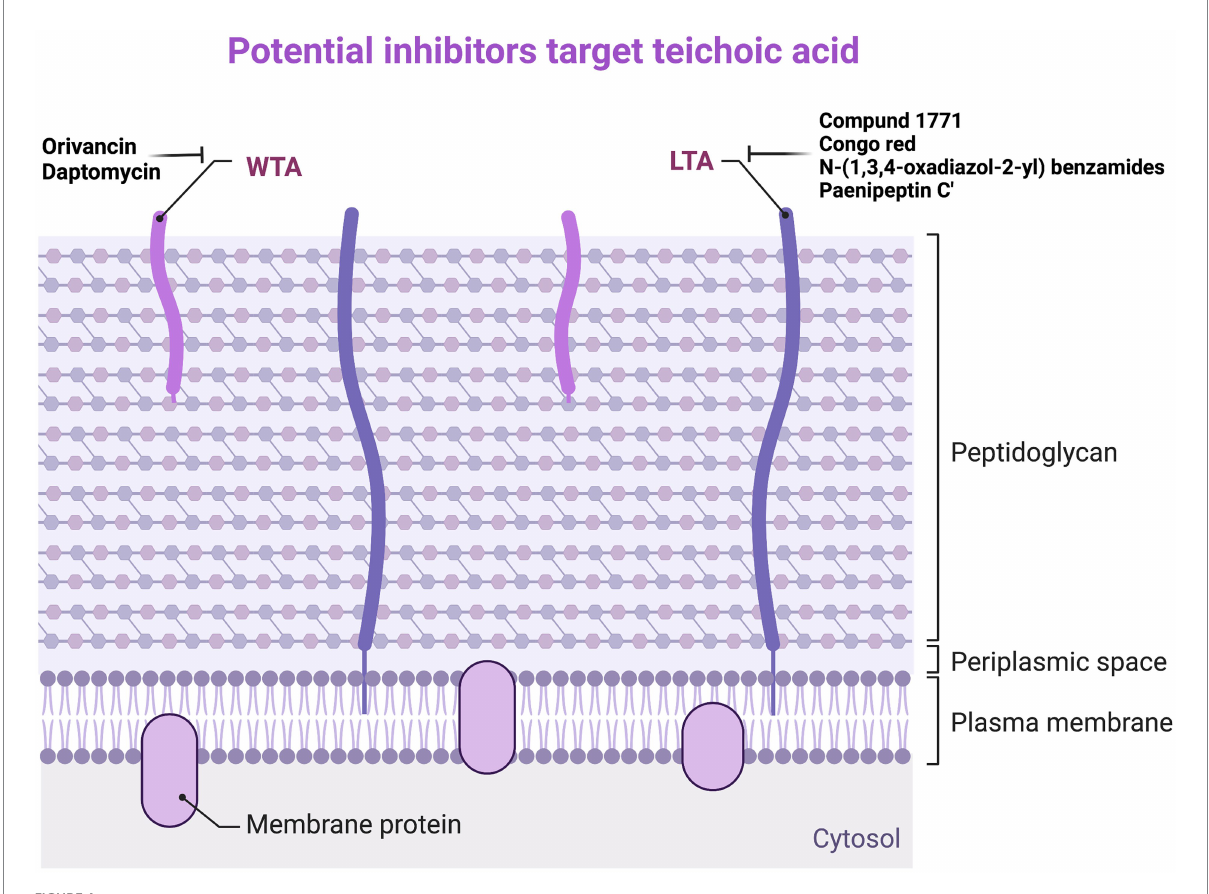
FIGURE 4 Potential inhibitors target teichoic acid. WTA, wall teichoic acid; LTA, lipoteichoic